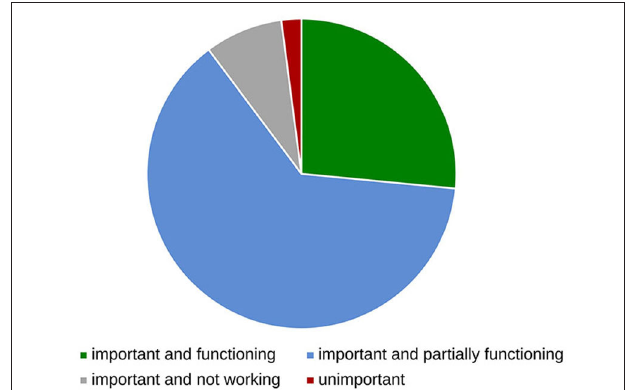
FIGURE 5 | Relationships between actors and their importance, n = 41. Answers to the multiple-choice question: How do you perceive the RELATIONSHIPS between the different actors in your LAG and their IMPORTANCE for sustainable development